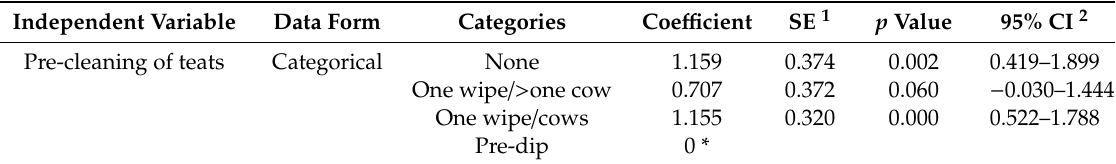
Table 10. Final generalized linear mixed model based on 120 farm visits describing risk factors ( = independent variable) associated with log 10 -transformed teat-skin load at herd level with total aerobic mesophilic bacteria ( = dependent variable).